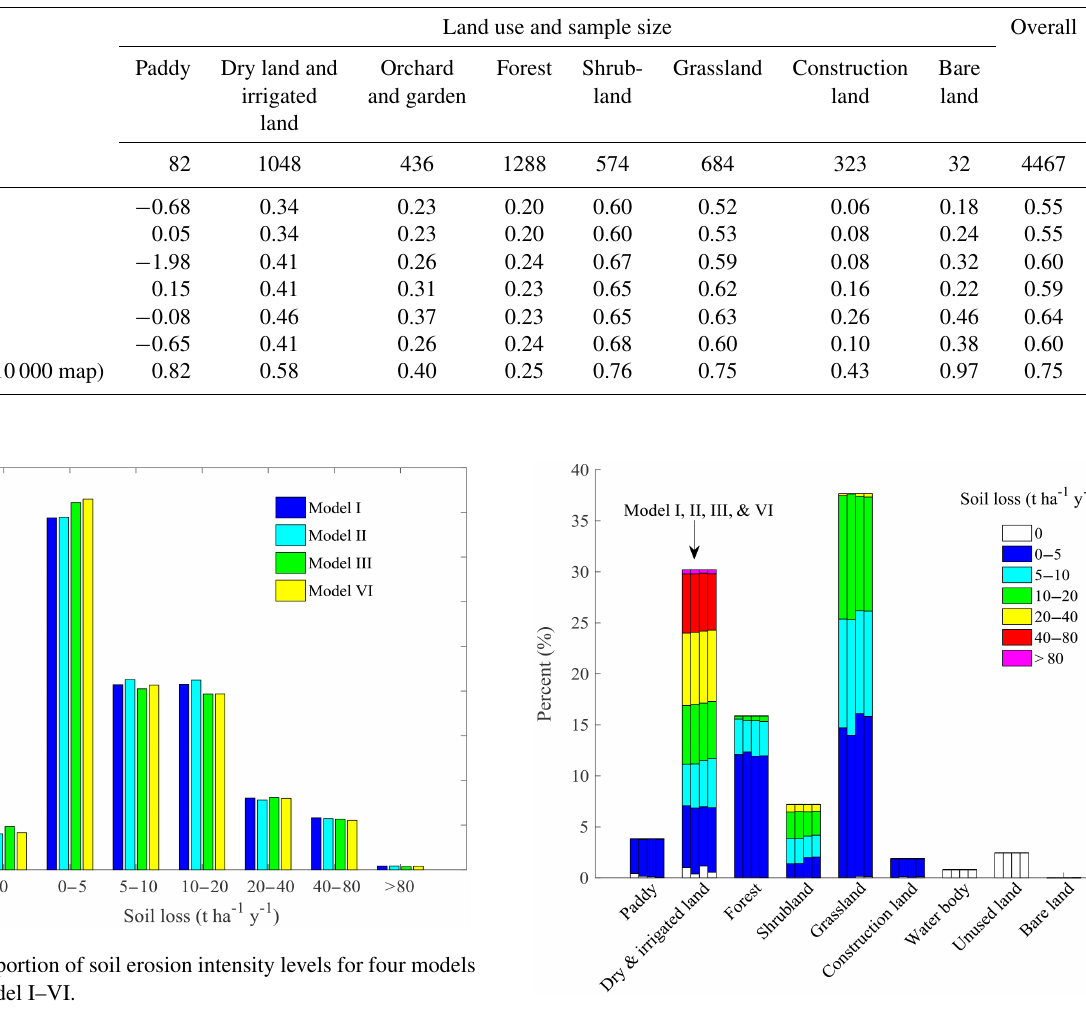
Figure 8. Proportion of soil erosion intensity levels for different land use for four models including Model